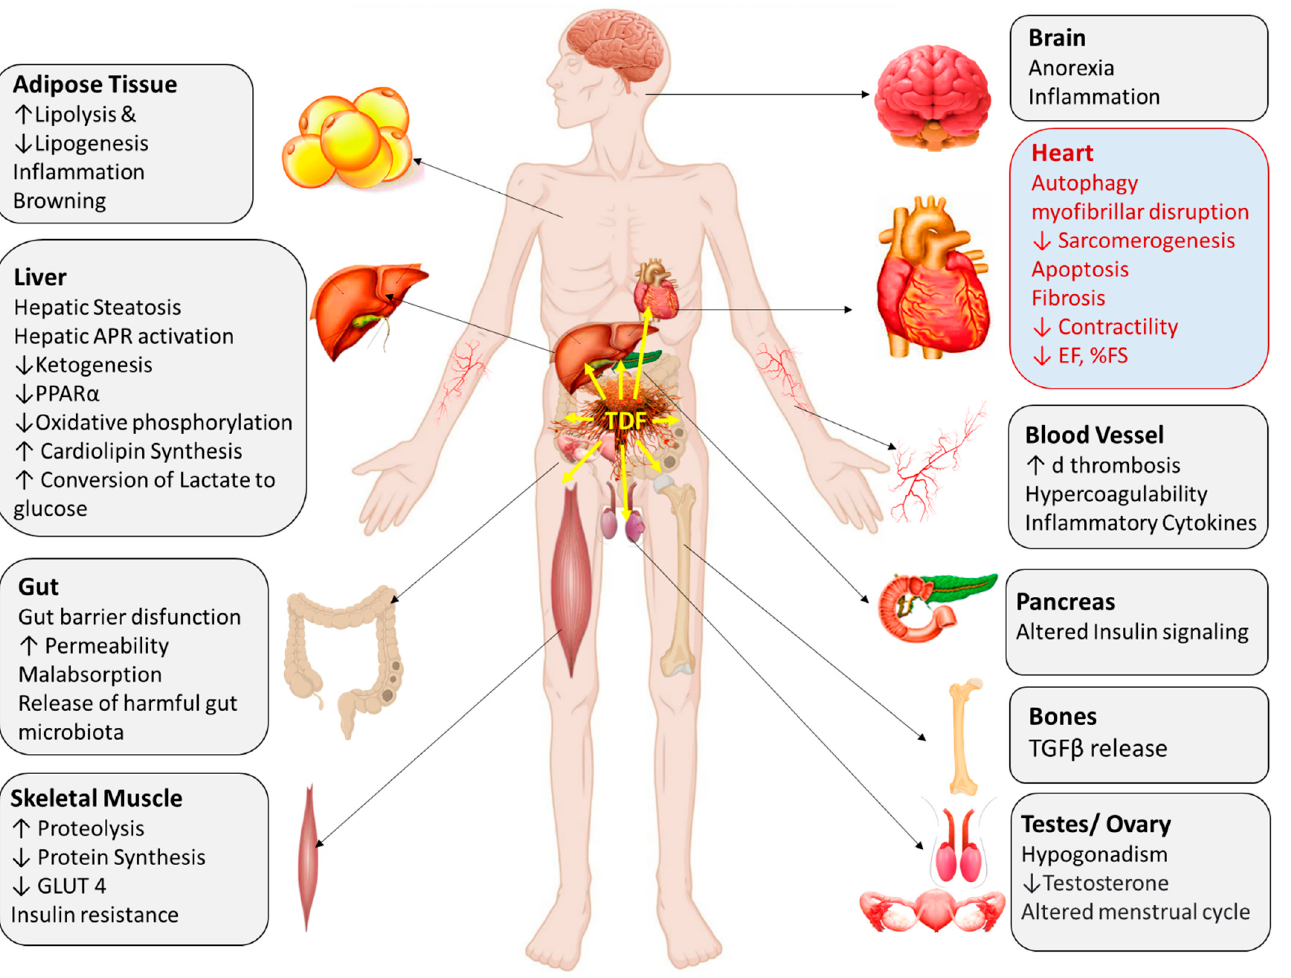
Figure 1. Cancer-induced cachexia involves multiple organs, including the heart and is a systemic phenomenon. GLUT: glucose transporter, APR: acute phase response, PPAR: peroxisome proliferator-activated receptors, EF: ejection fraction, FS: fractional shortening, TDF: tumor-derived factor. “ ↑ ” denotes increase. “ ↓ ” denotes decrease. Redrawn with modification from ref [5] .